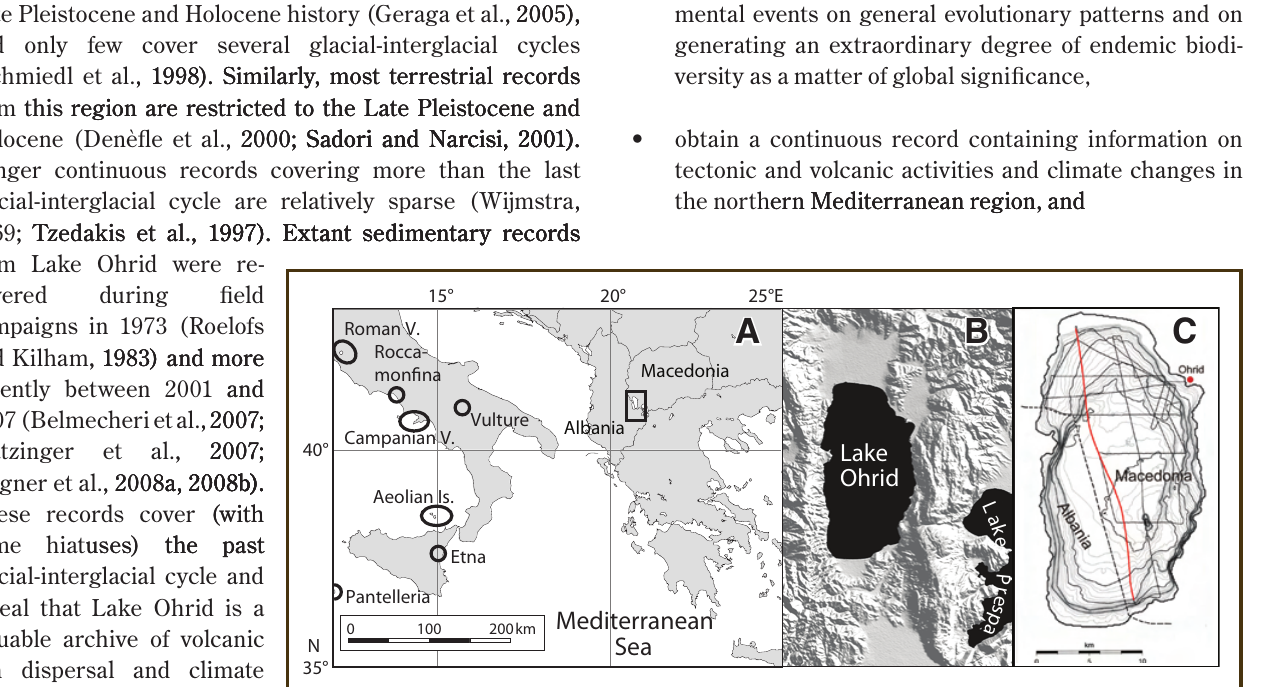
Figure 1. [A] Map of the northern Mediterranean region showing the study area (rectangle) and Italian volcanic regions (circles). [B] The digital elevation model of Lake Ohrid at the Albanian/Macedonian border showing that the lake is part of a NNW to SSE striking graben system. [C] Bathymetry of Lake Ohrid with 25-m contour intervals. The dashed line indicates the border between Albania and Macedonia; the red line shows the position of the seismic profile shown in Fig.